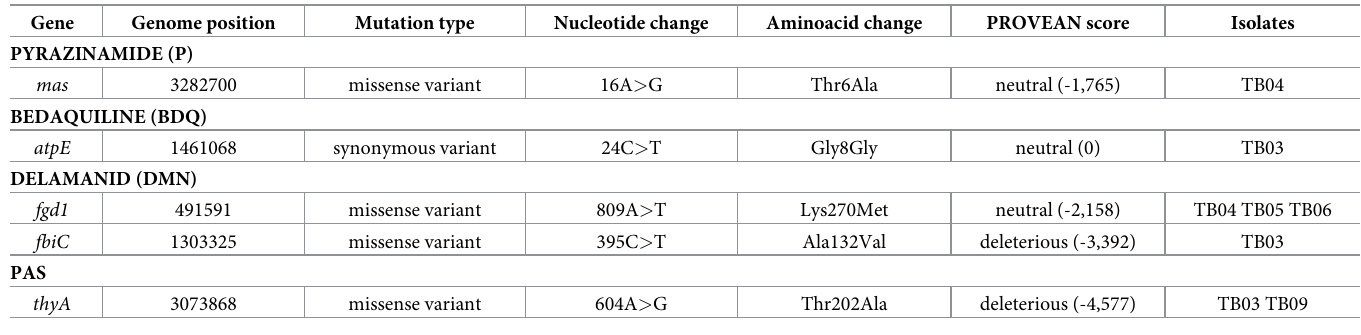
Table 2. Mutations no reported in ReseqTB in loci related to antituberculosis therapy detected by WGS analysis from isolates of Chinchina´.